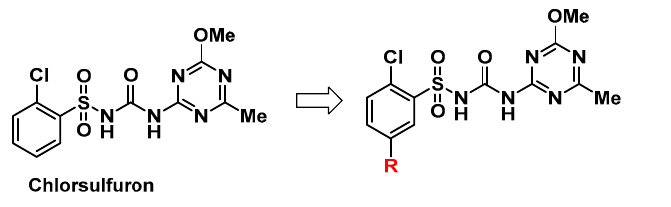
Figure 2. The Structure of 5-dialkylamino substituted compounds.